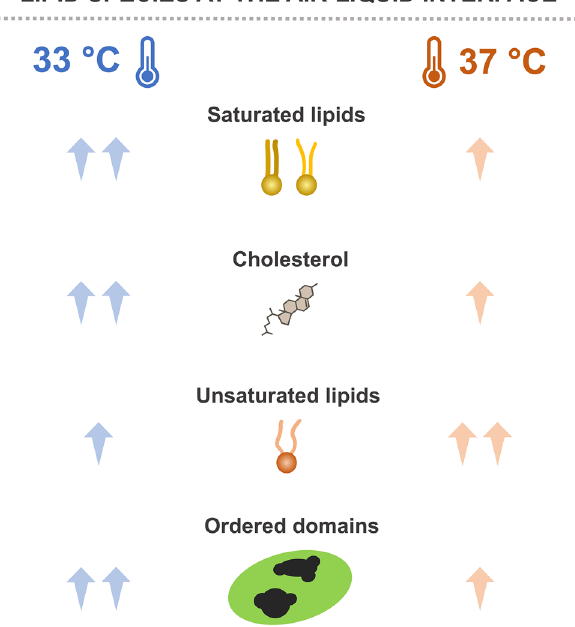
Figure 6. Schematic representation of possible candidates involved in the temperature-mediated improvement of surfactant performance and structural changes at the air–liquid interface. Our findings suggest the presence of higher levels of cholesterol and saturated lipids (mainly DPPC) along with reduced amount of unsaturated lipid species at 33 °C compared with 37 °C. This promotes the formation of ordered condensed domains with bigger size at hypothermia temperature compared with 37